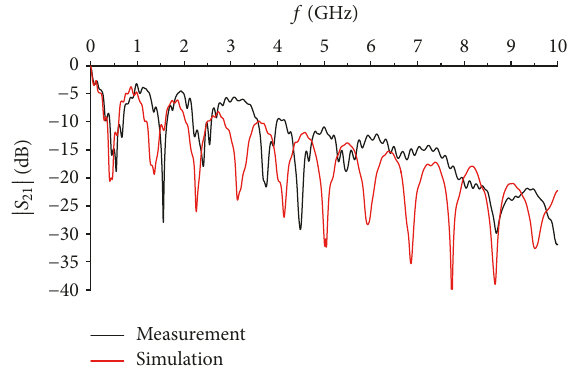
Figure 19: The measured and simulated frequency dependencies of |𝑆 | for the experimental 21